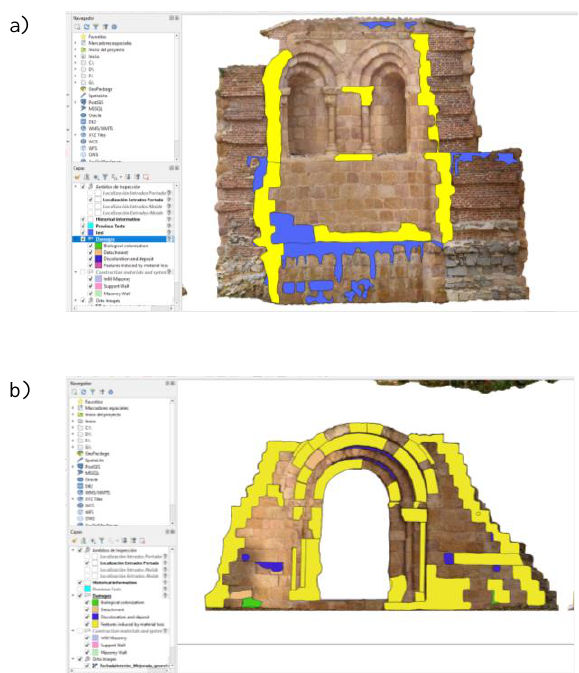
Figure 12: Result of the intersection carried out for selecting the features induced by material loss: a) at the intrados of the apse and; b) at the intrados of the façade. The selection is highlighted in yellow.